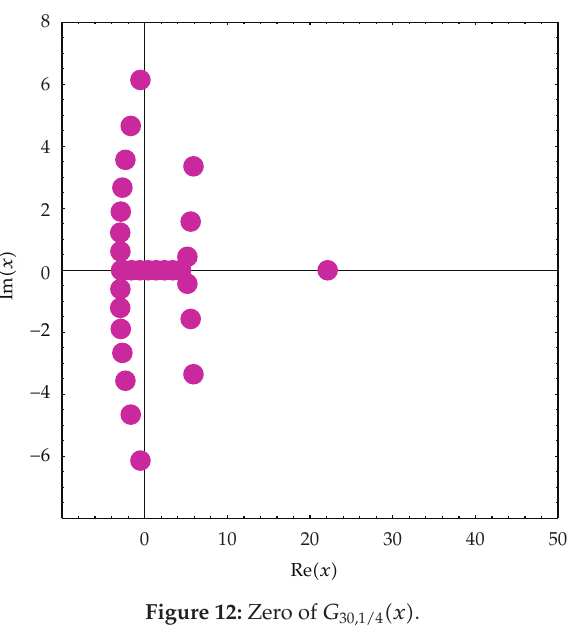
Figure 12: Zero of G 30 , 1 / 4 (cid:2) x (cid:3) .